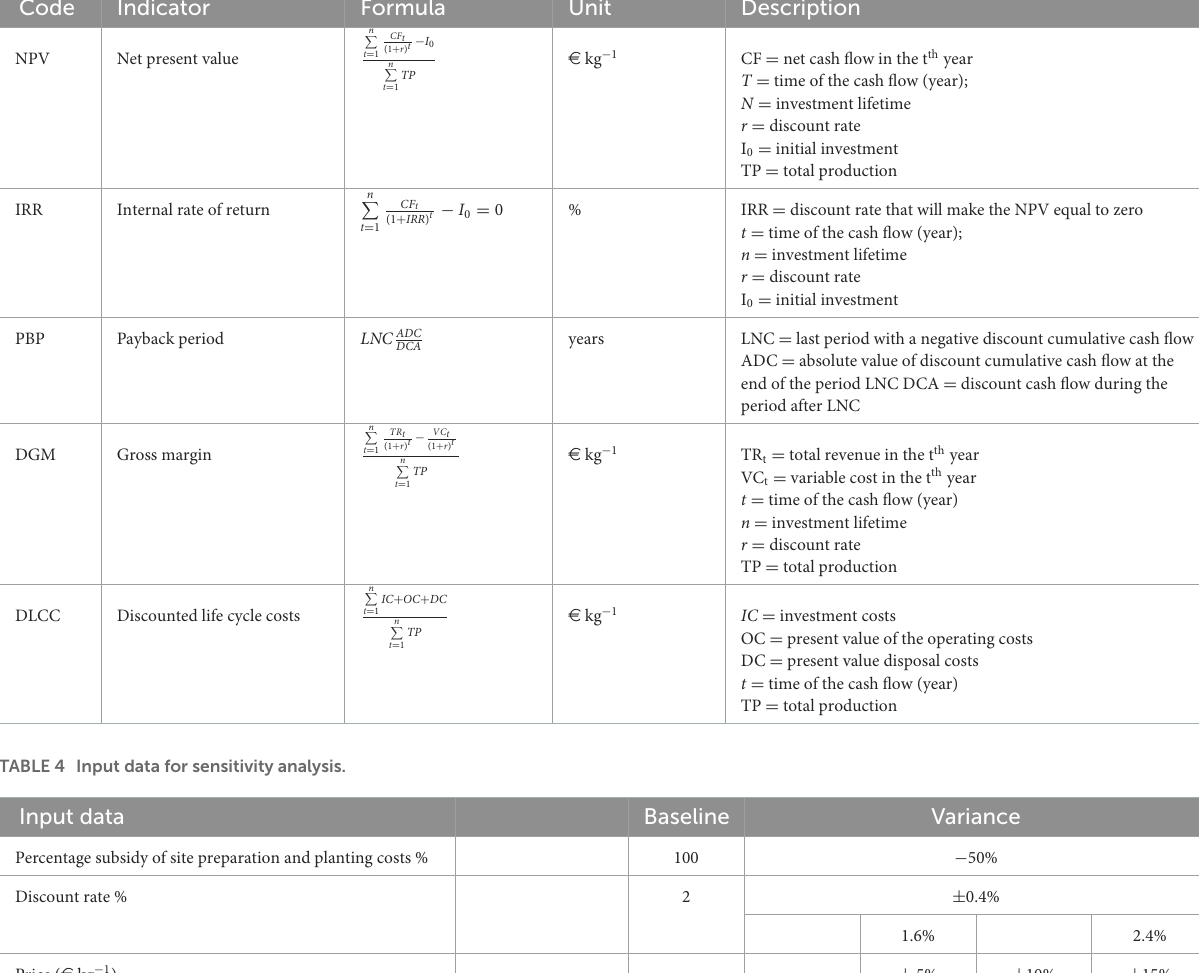
TABLE 3 Investment analysis implementation.